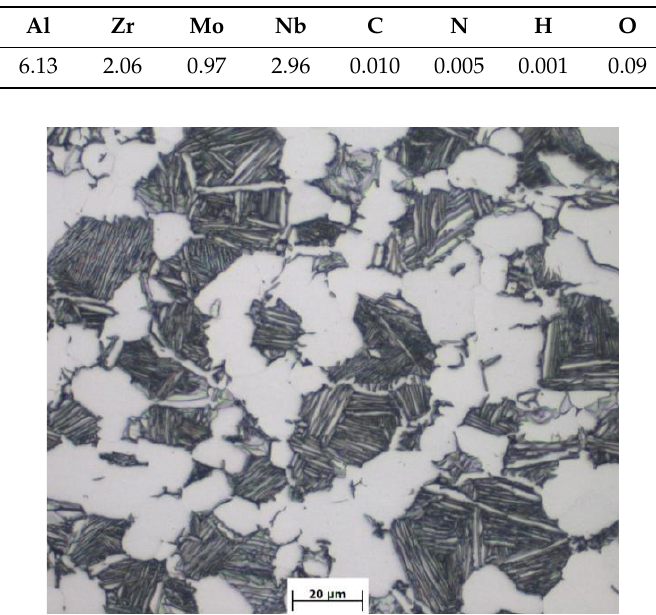
Table 1. Chemical composition of the TA31 titanium alloy (mass fraction, %).